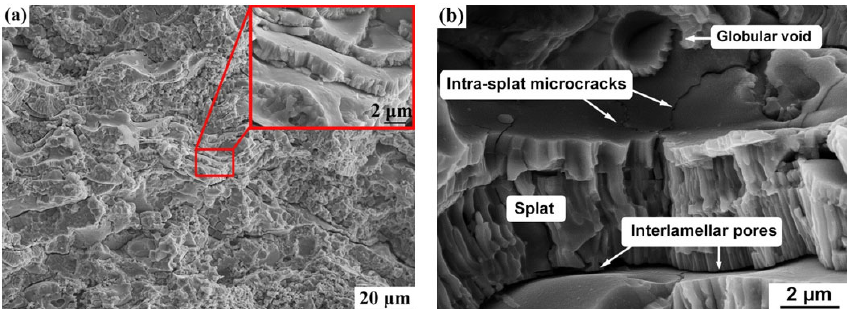
Fig. 28 Structural characteristics of plasma-sprayed TBCs: (a) lamellar structure formed by layer-stacking. Reproduced with permission from Ref. [7], © ASM International 2015. (b) Three kinds of pores. Reproduced with permission from Ref. [148], © ASM International 2013.